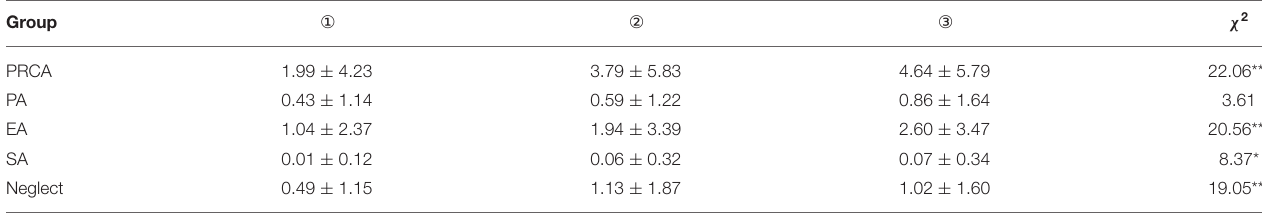
TABLE 2 | Nonparametric test of childhood maltreatment at different depression status. Group